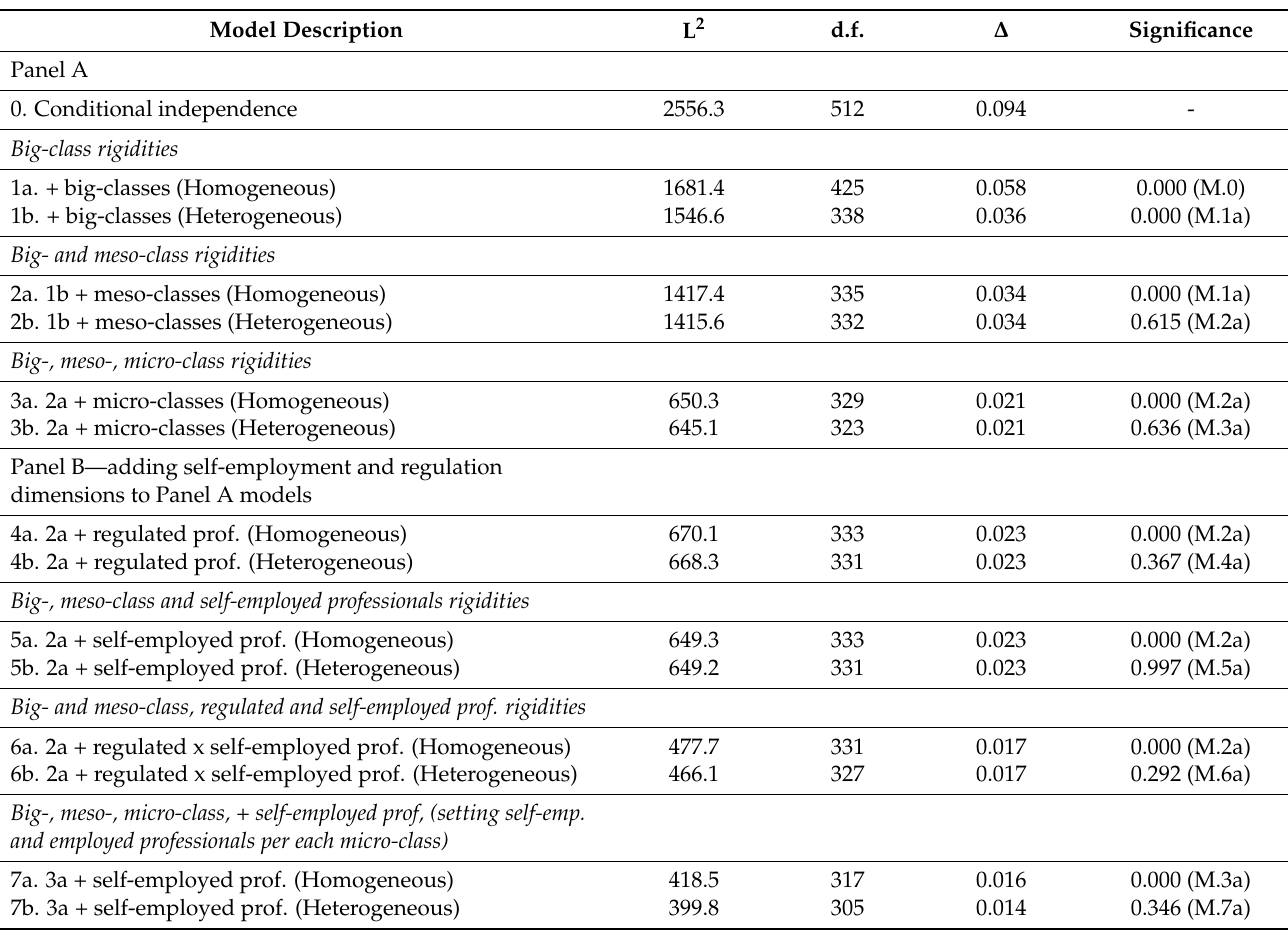
Table 2. Fit indices of log-linear models of quasi perfect mobility with big-, meso- and micro-class rigidities with regulation and self-employment specification (N.